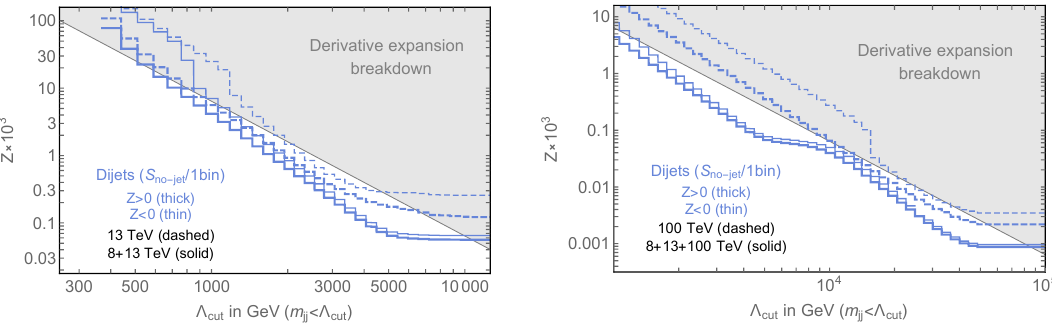
Figure 8 . (cid:3) cut plot for the projected 95% CL limits at 13 TeV and a future 100 TeV circular pp collider, extracted from dijet searches. The dashed lines show the results of the (cid:12)t using S no-jet and the central rapidity bin, only at a given center of mass energy. We assume an integrated luminosities of 300 fb (cid:0) 1 at 13 TeV, and 10 ab (cid:0) 1 at 100 TeV. The solid lines show the e(cid:11)ect of combining di(cid:11)erent center of mass energies to constrain the PDFs. The combination assumes 20 fb (cid:0) 1 at 8 TeV and 3 ab (cid:0) 1 for the 13 TeV dataset in the 8+13+100 TeV combination. The